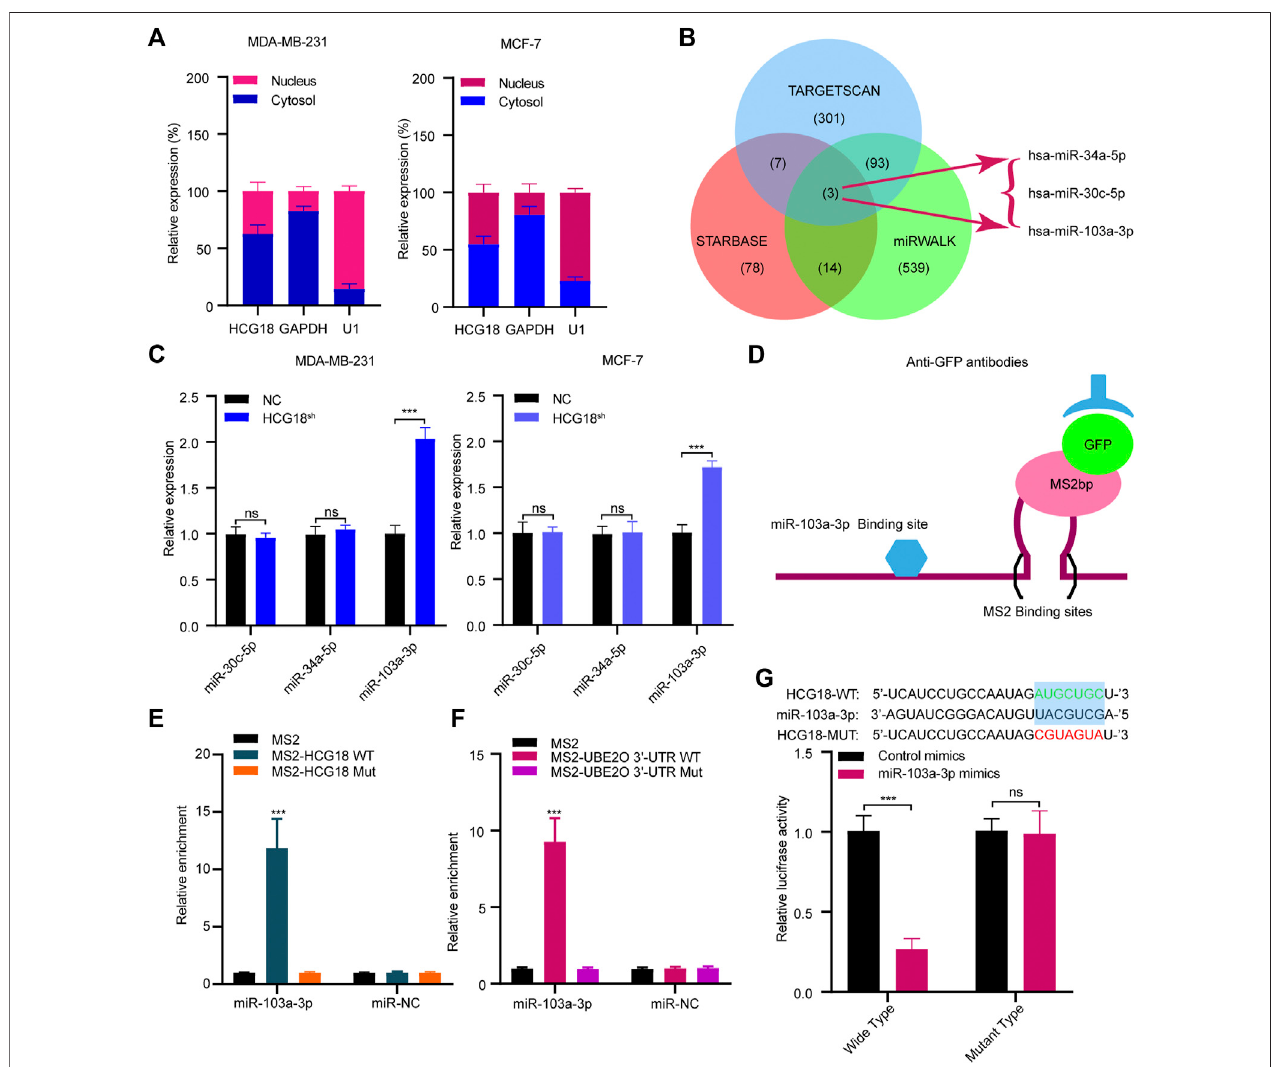
FIGURE 6 | (A) Nucleocytoplasmic separation assays were used to con fi rm the cytoplasmic and nuclear distribution of components in BC cells. (B) Schematic illustration showing the overlapping miRNAs targeting both HCG18 and UBE2O using the TargetScan, miRWalk, and starBase databases. (C) qRT-PCR was used to determine theexpression ofpredictedmiRNAs inMDA-MB-231 NC /MDA-MB-231 HCG18-sh andMCF-7 NC /MCF-7 HCG18-sh cells. (D,E) MS2-RIP followed bymiRNAqRT- PCR to detect the interactions between miRNAs and HCG18. (F) MS2-RIP followed by miRNA qRT-PCR to detect the interactions between miRNAs and UBE2O mRNA 3 ′ -UTR. (G) HCG18-Wt/HCG18-mut and miR-103a-3p mimics were cotransfected into HEK-293T cells, and then dual-luciferase reporter assays were performed. The data are shown as the mean ± SD. * p < 0.05, ** p < 0.01, *** p < 0.001. The data represent at least three independent experiments.